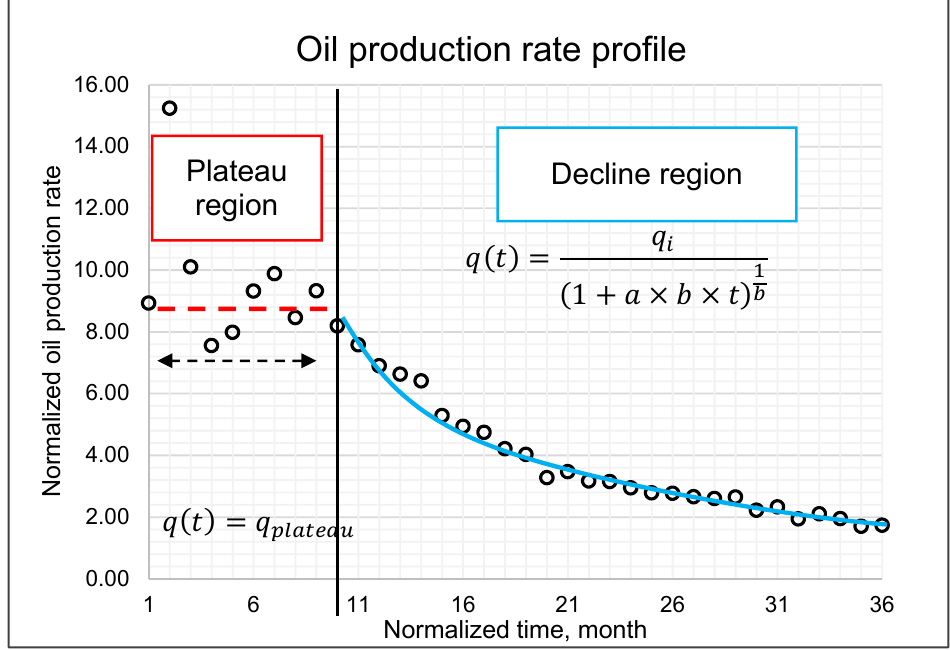
Figure 12. Curve fitting scheme applied to production histories.